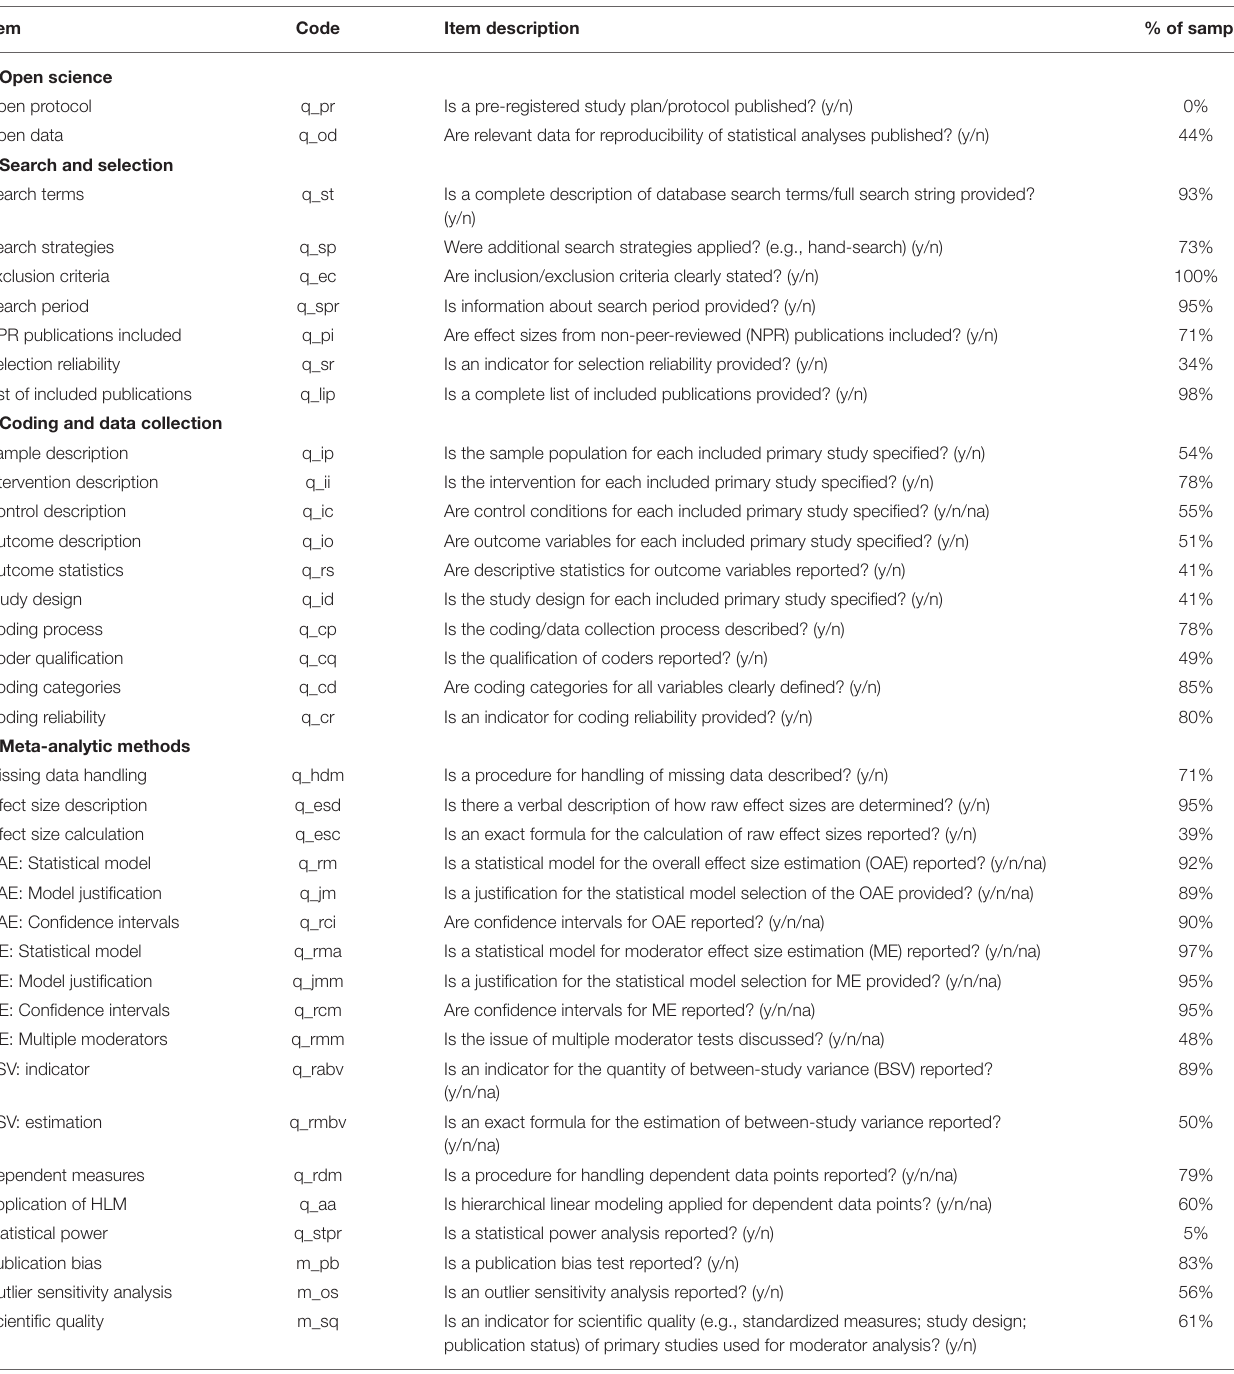
TABLE 3 | Scientific